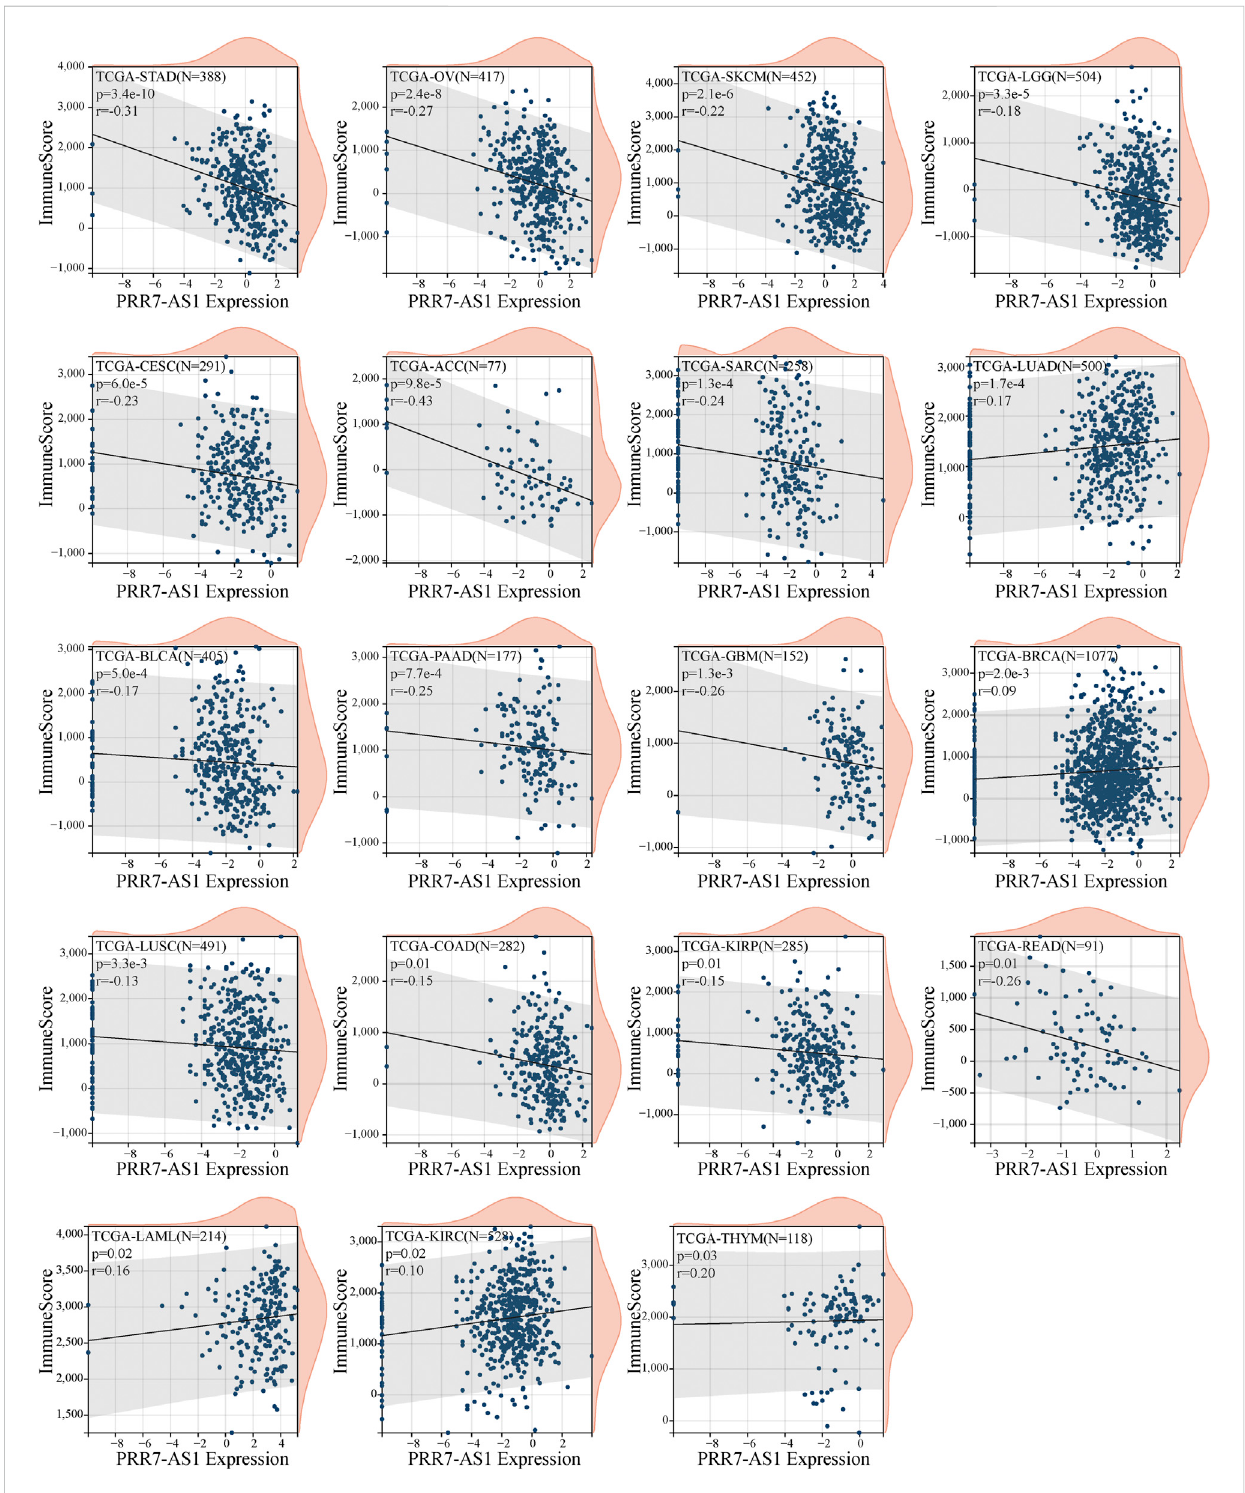
Correlation between PRR7-AS1 expression levels and immune score in pan-cancer. Correlation was tested by Spearman